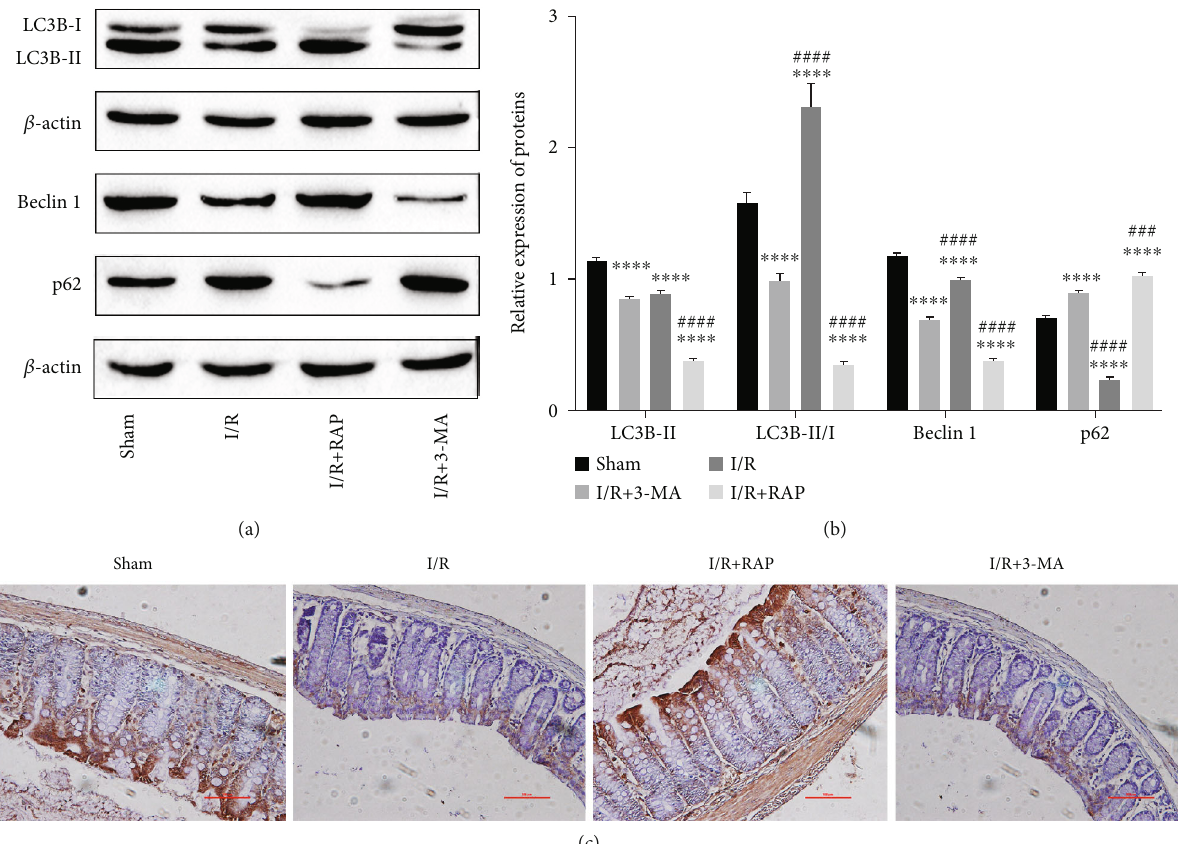
Figure 4: The e ff ects of 3-MA and RAP on autophagy levels in intestinal tissues after IRI. (a) The representative bands of Western blotting. (b) The relative expression levels of LC3B, Beclin 1, and p62. (c) Representative images of immunohistochemical staining for LC3B in each group. ∗∗∗ P < 0 : 001 , ∗∗∗∗ P < 0 : 0001 vs. the sham group; ### P < 0 : 001 , #### P < 0 : 0001 vs. the I/R group. n = 5 per group in the sham and I/R groups, and n = 10 per group in the other